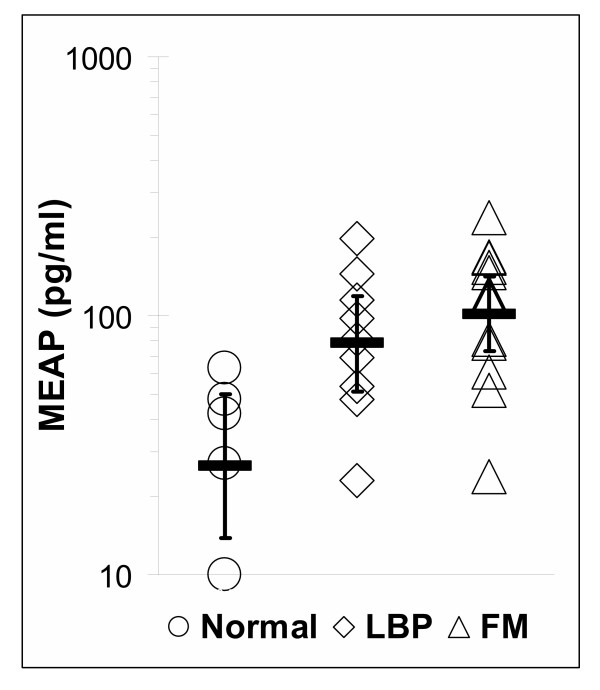
Met-Enkephalin-Arg6-Phe7 (MEAP) concentrations (pg/ml) in cerebrospinal fluid (CSF) from normal (circles), low back pain (LBP, diamonds) and fibromyalgia (FM, triangles) subjects. The bars indicate geometric means and 95% confidence intervals. The groups were significantly different by ANOVA (p = 0.0014). MEAP in the FM (p < 0.01) and LBP (p < 0.05) groups were significantly higher than Normal (2-tailed unpaired Student's t-tests).